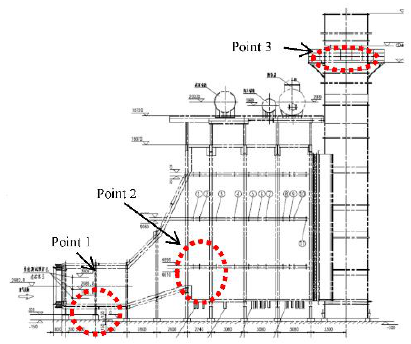
Figure 12. Arrangement of measuring points in the HRSG.